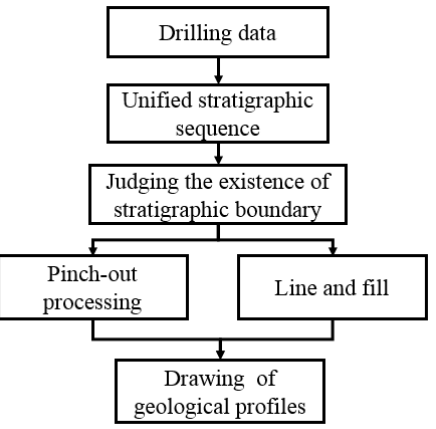
Figure 1. Principle of proposed unique path method based on a unified stratigraphic sequence.